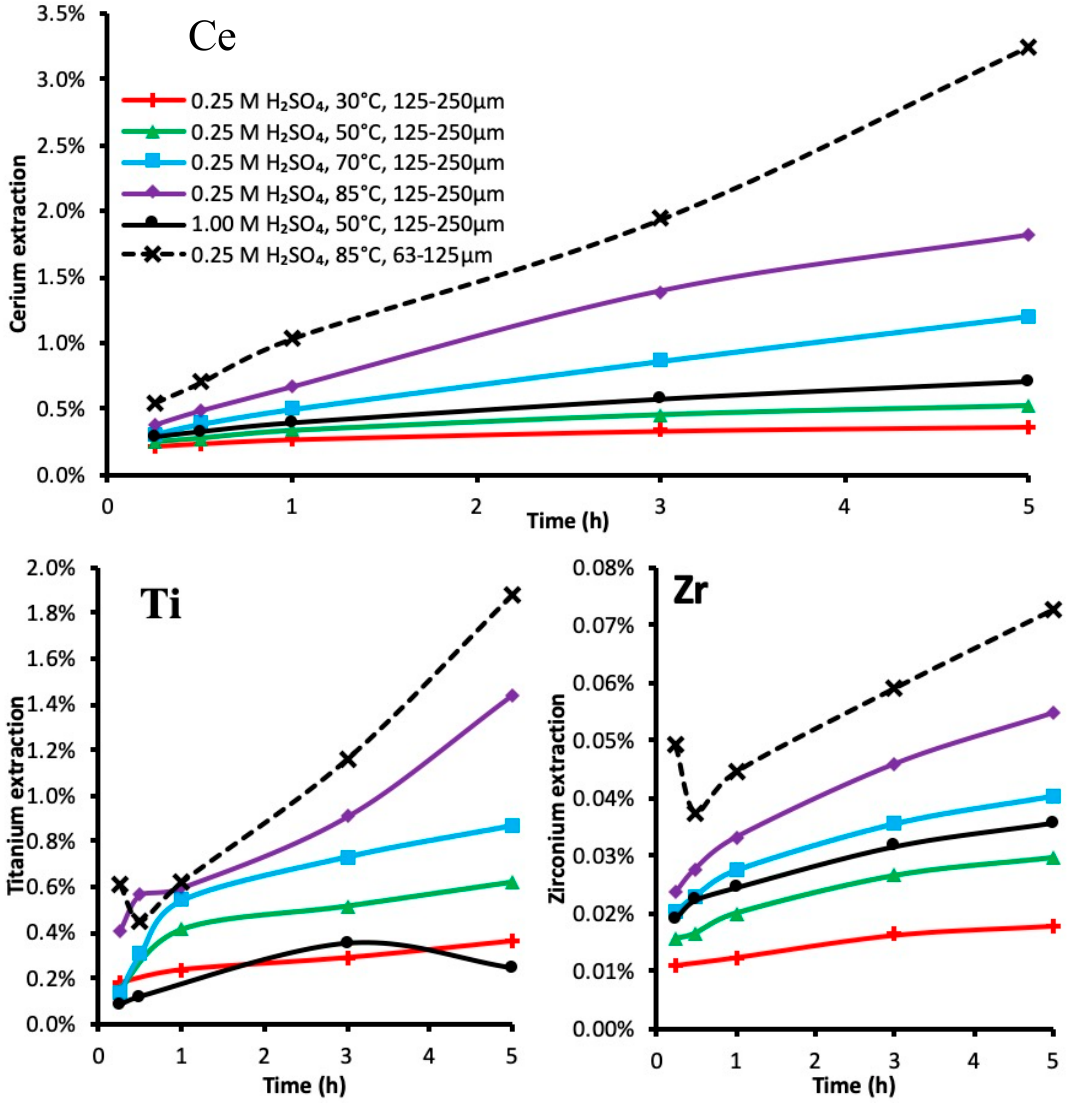
Figure 5. Leaching kinetics under various conditions in sulphuric acid media.